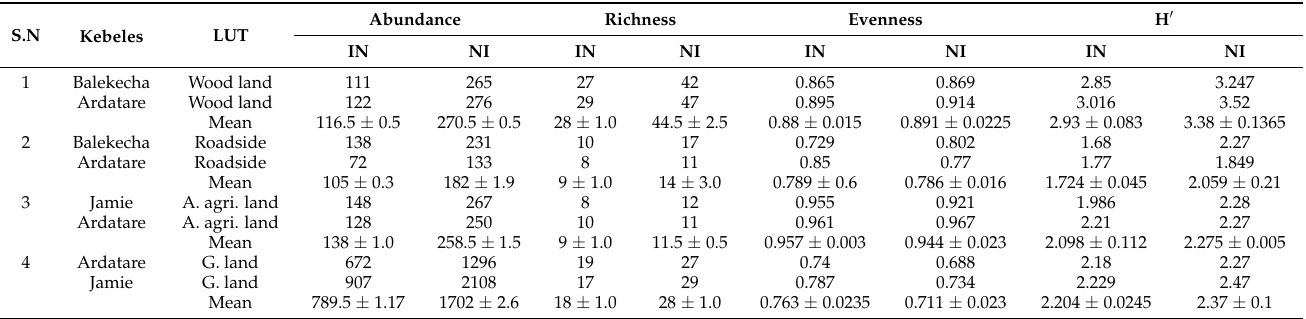
Table 1. Mean species abundance, richness, evenness, and diversity for invaded and non-invaded land units among different land use types in Ginir